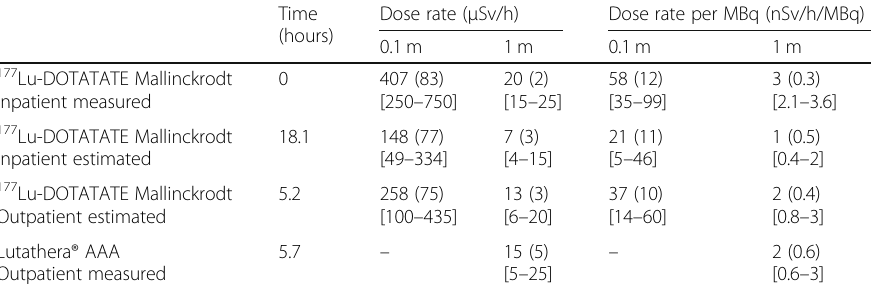
Table 3 Mean (SD) [range] measured and estimated dose rates and dose rate per MBq administered activity at 0.1 and 1 m from the